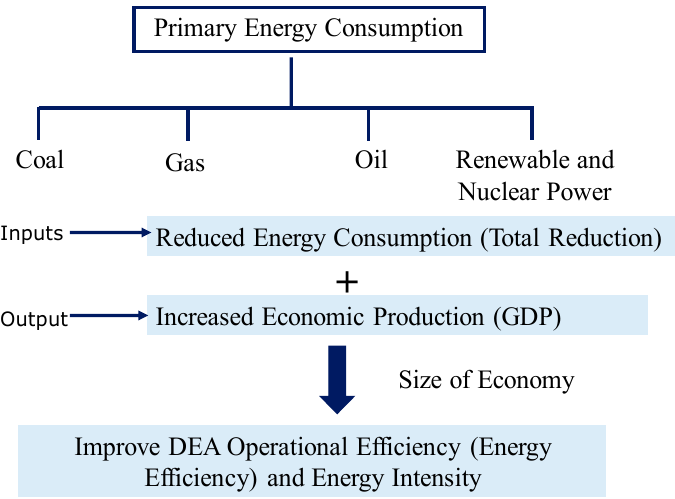
Figure 1. Research structure of energy intensity and GDP. Note: (a) The authors have prepared the figure for this research. (b) We need to reduce the amount of energy consumption based on coal, gas, and oil to reduce CO 2 emission. Renewable and nuclear power generations can reduce the amount of CO 2 emission. However, they suffer from another type of difficulty. For example, renewable energy has high setup and maintenance costs and low energy density. It is also influenced by weather conditions, so its intermittency avoids it to become a base load. Nuclear energy suffers from the problem of “nuclear waste” after the generation. Hence, in this study, we believe that a reduction in the energy consumption is better. Of course, we understand the importance of such renewable energy sources in reducing the emission of greenhouse gas. (c) “Electricity” is a secondary energy, so that this study does not include it as energy consumption.